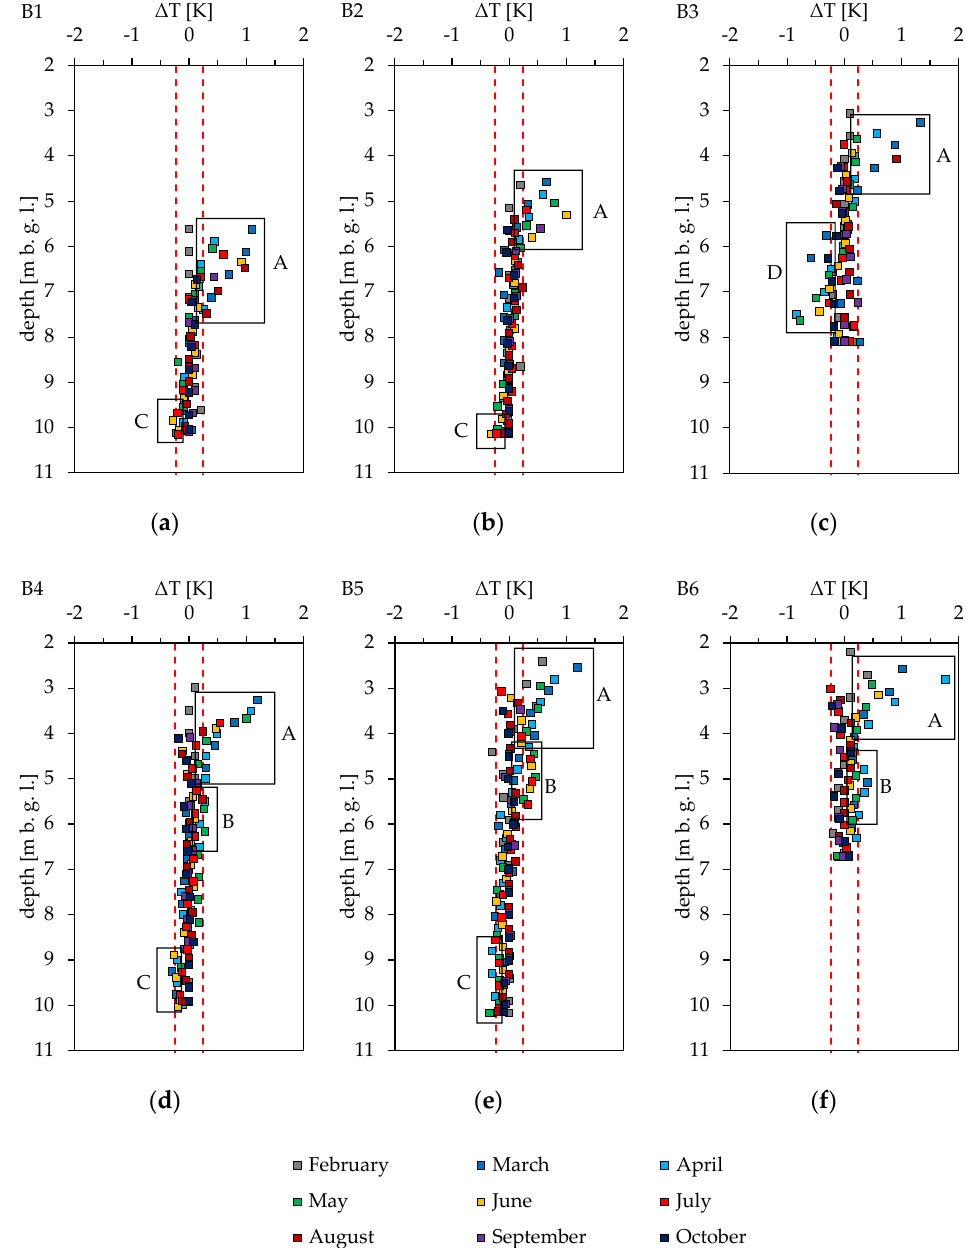
Figure 3. Values of ∆ T for all boreholes; ( a ) B1; ( b ) B2; ( c ) B3; ( d ) B4; ( e ) B5 and ( f ) B6. The area within the dashed red lines indicates the measurement accuracy of the TLC-meter ( ∆ T ≤ 0.2 K). Temperature differences outside of the dashed lines are considered significant. Areas with clusters of significant ∆ T values (areas A, B, C and D), as described in the text, are